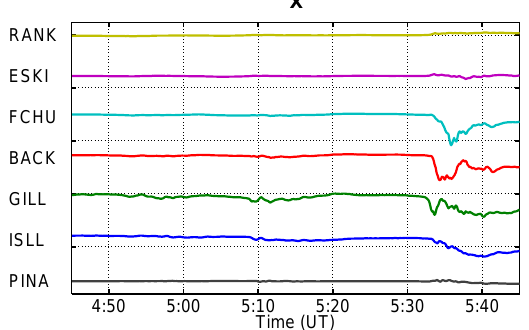
Fig. 2. X-component magnetometer traces from the Churchill line of magnetometer stations on 15 November 1992. A large magnetic bay signature is observed just after 05:30 UT and is particularly clear in the FCHU and BACK